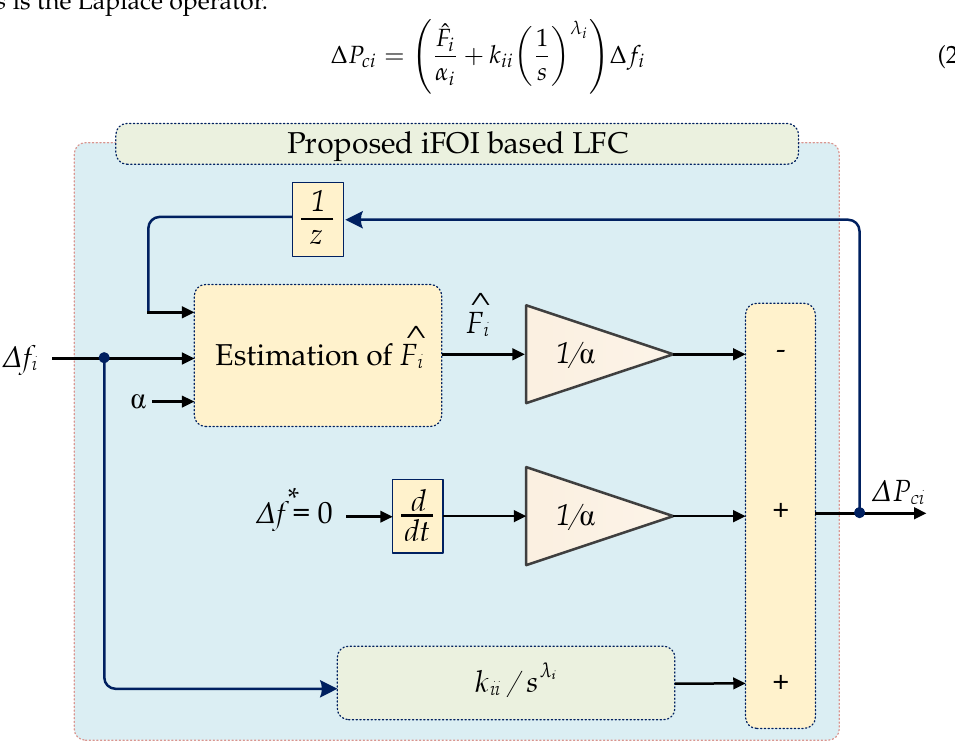
Figure 5. Structure of the proposed iFOI for the secondary controller for each area.